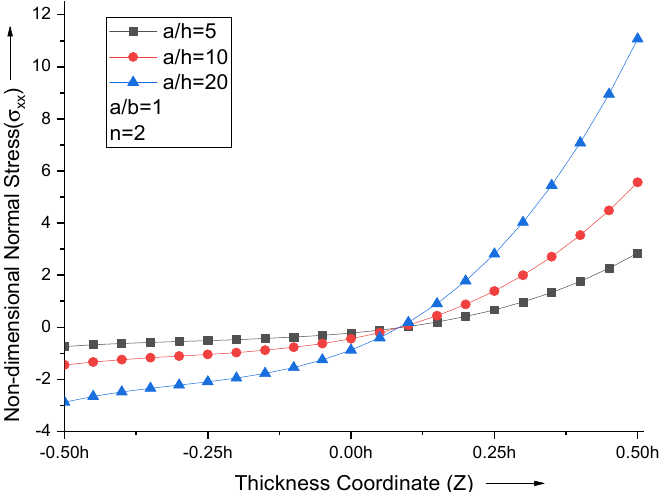
Figure 7. Effect of side − to − thickness ratio (a/h) on non − dimensional normal stresses of the plate.